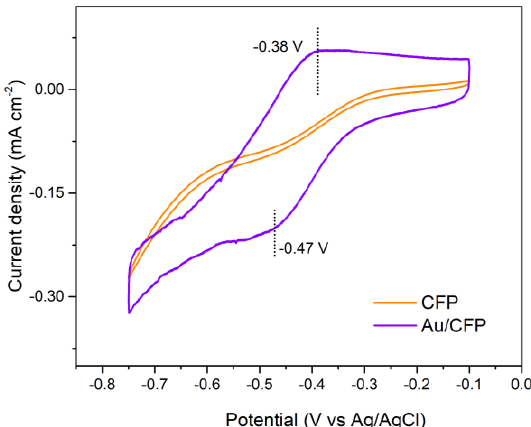
Figure 4. Pd−upd voltammetric profile of as−deposited Au/CFP and clean CFP electrodes (0.5 × 1 Figure 4. Pd − upd voltammetric profile of as − deposited Au/CFP and clean CFP electrodes cm 2 ). Scan rate: 50 mV/s. (0.5 × 1 cm 2 ). Scan rate: 50